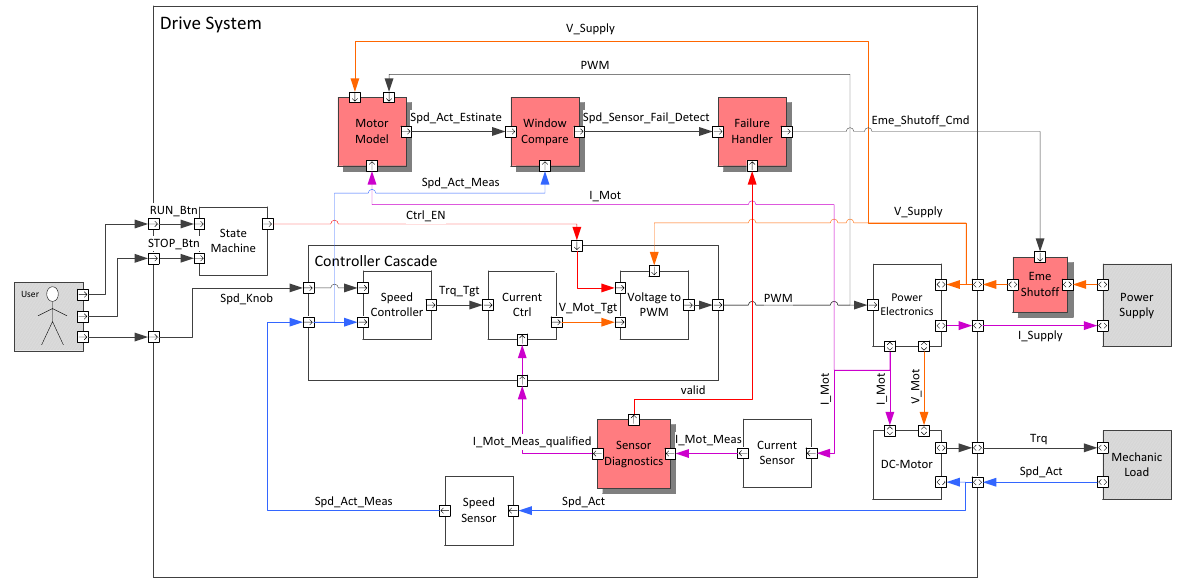
Figure 8. Functional system